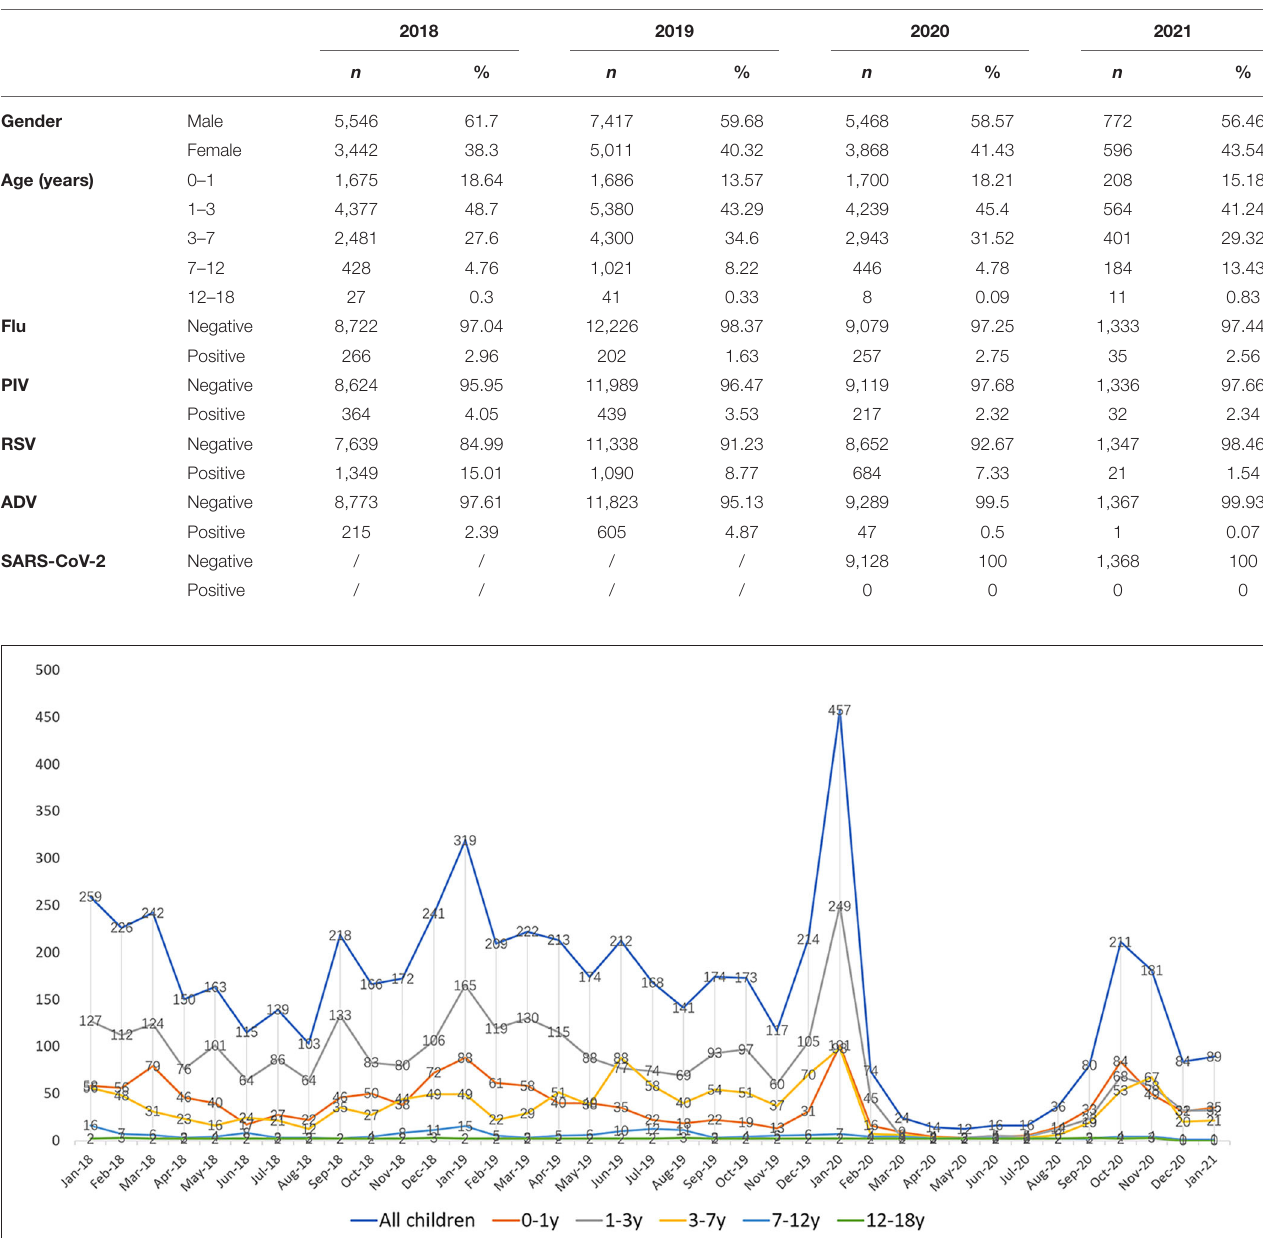
TABLE 1 | Baseline for children admitted to Xiamen Children’s Hospital and tested for respiratory pathogens from January 1, 2018 to January 31, 2021.